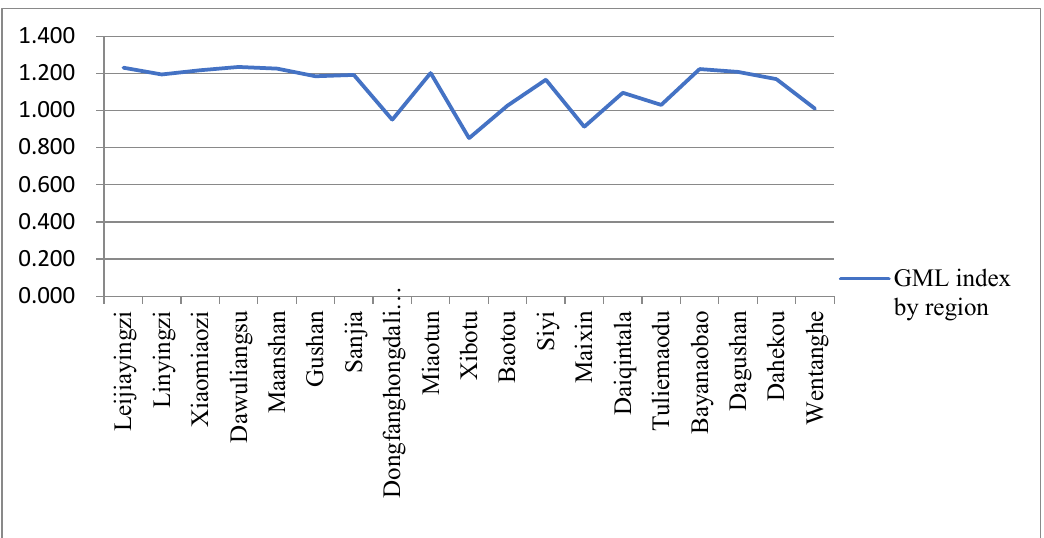
Figure 5. GML index of rural preservation and inheritance value assessment by year in the Western Liao River Basin, Inner Mongolia, China.